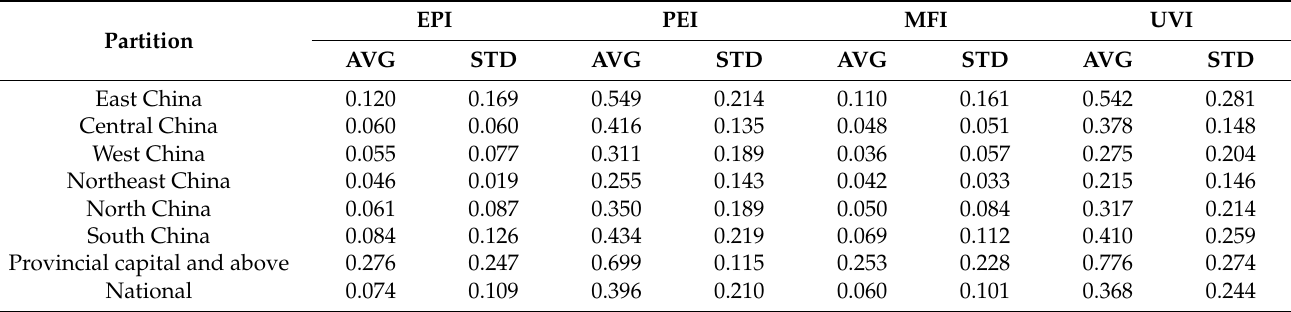
Table 4. Statistics of four types of indexes by region and